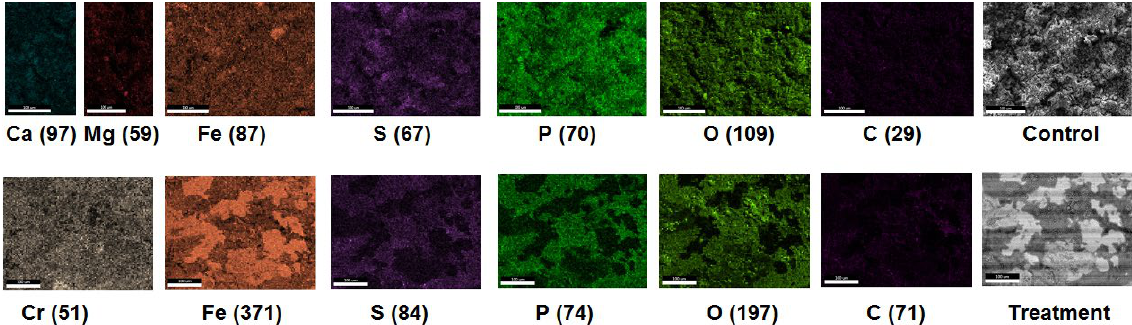
Figure 2. EDS elemental maps of N80 steel samples incubated in SRB contaminated anaerobic environment for 90 days at 37 °C (control) (First raw) and incubated in SRB contaminated anaerobic environment for 60 days at 37 °C then treated by biocide2 CHIMEC 7660 and left for another 30 days at 37 °C (Treatment) (Second raw). Scale bars represent 100 µm in all maps. The numbers next to each map refer to element distribution regions of interest (ROIs). The lighter colored image for each element refers to a higher concentration for this element in the studied